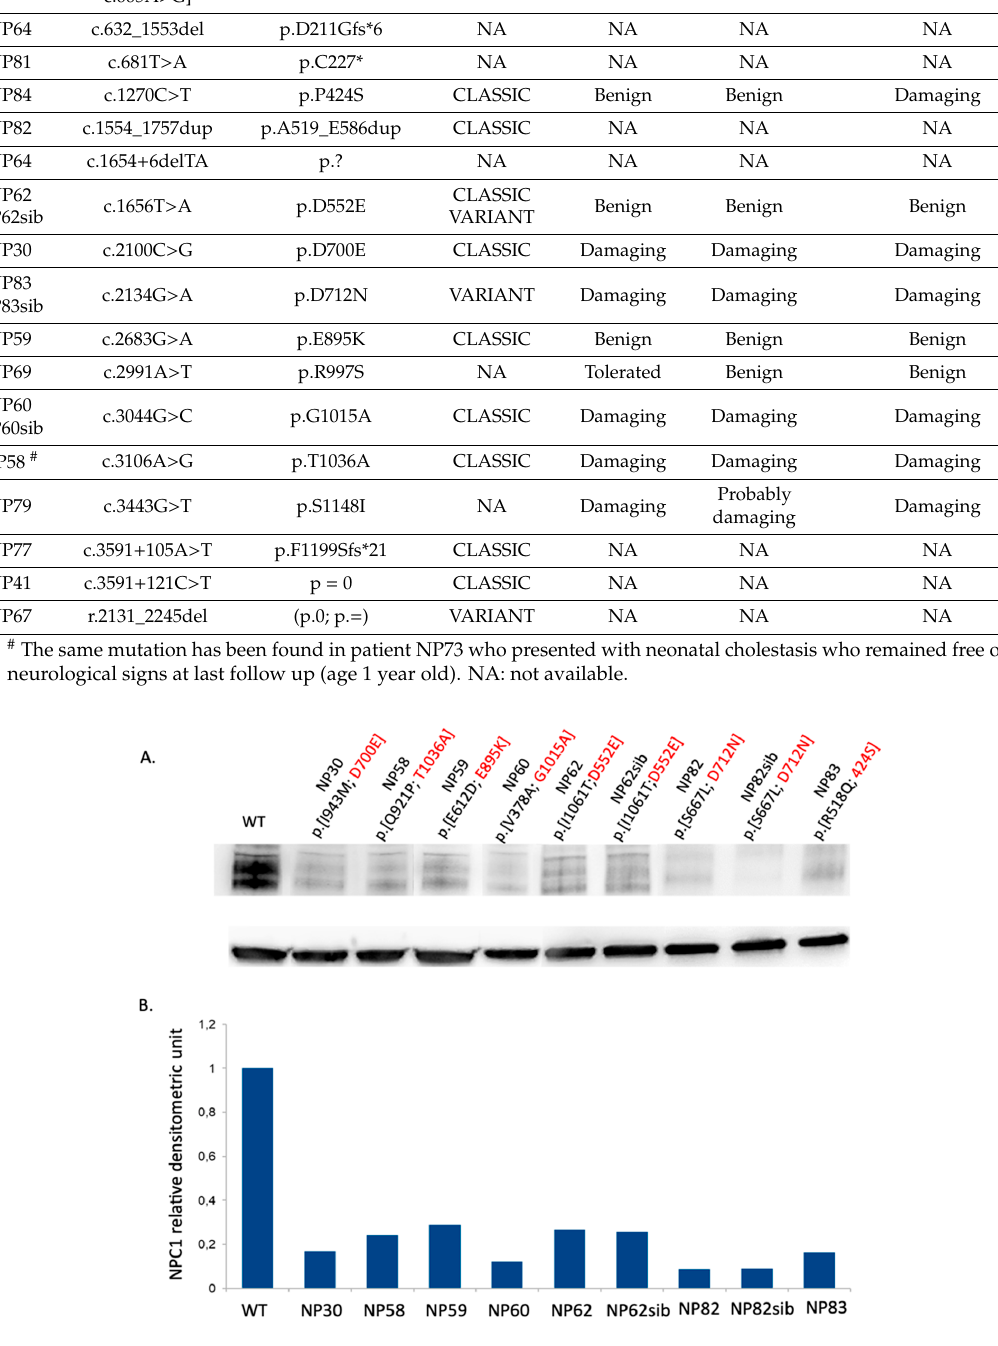
NPC1 protein abundance in patients carrying seven novel missense mutations. ( A ) Representative western blot analysis of NPC1 protein expression in NPC patients and normal control fibroblast cell lines. ( B ) The intensity of the NPC1 signals was normalized against actin. The NPC1 protein content in NPC fibroblasts was expressed as a percentage of the NPC1 protein content found in fibroblasts from a normal control.